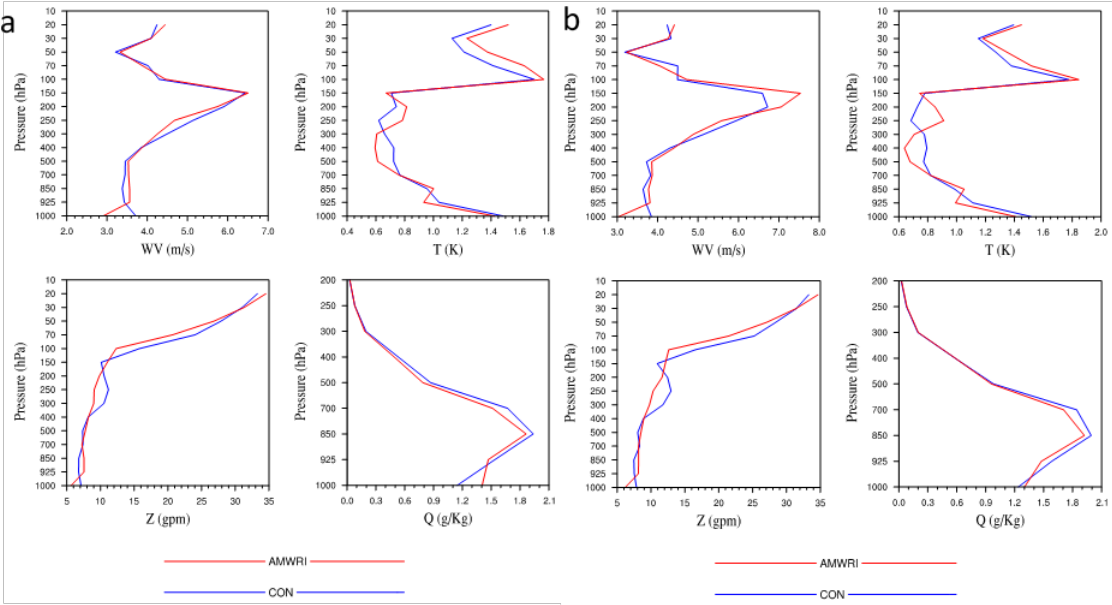
Figure 8. The aggregated root-mean-square errors of the ( a ) 24 h and ( b ) 48 h forecasts for vector wind, temperature, geopotential height, and specific humidity against the ECMWF analyses. The error statistics were obtained from 12 h and 48 h forecasts.